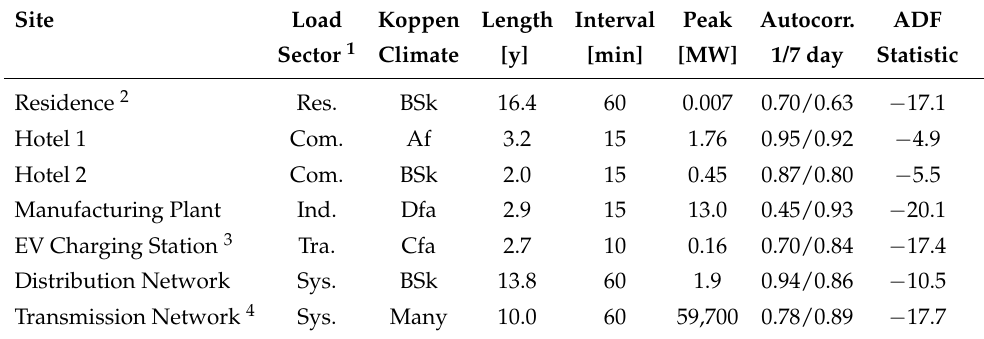
Table 2. Description of